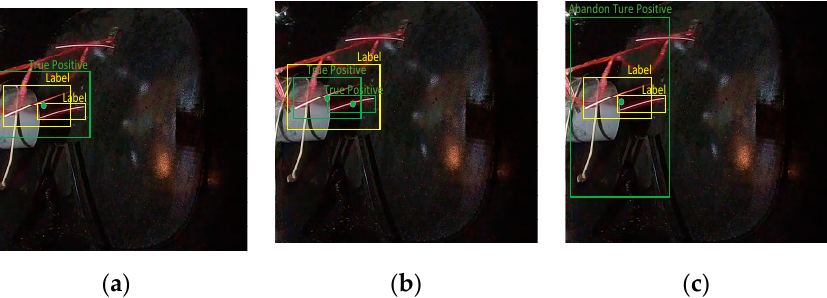
Figure 14. ( a , b ) contain two true positives identified by the additional rules, while ( c ) contains an abandoned true positive, as identified by additional rules. In ( a ), the green prediction box is located outside the yellow label box; in ( b ), the green prediction box is located inside the yellow label box; and, in ( c ), the green prediction box outside the yellow label box is so large and inaccurate that it is considered to be an abandoned true positive.